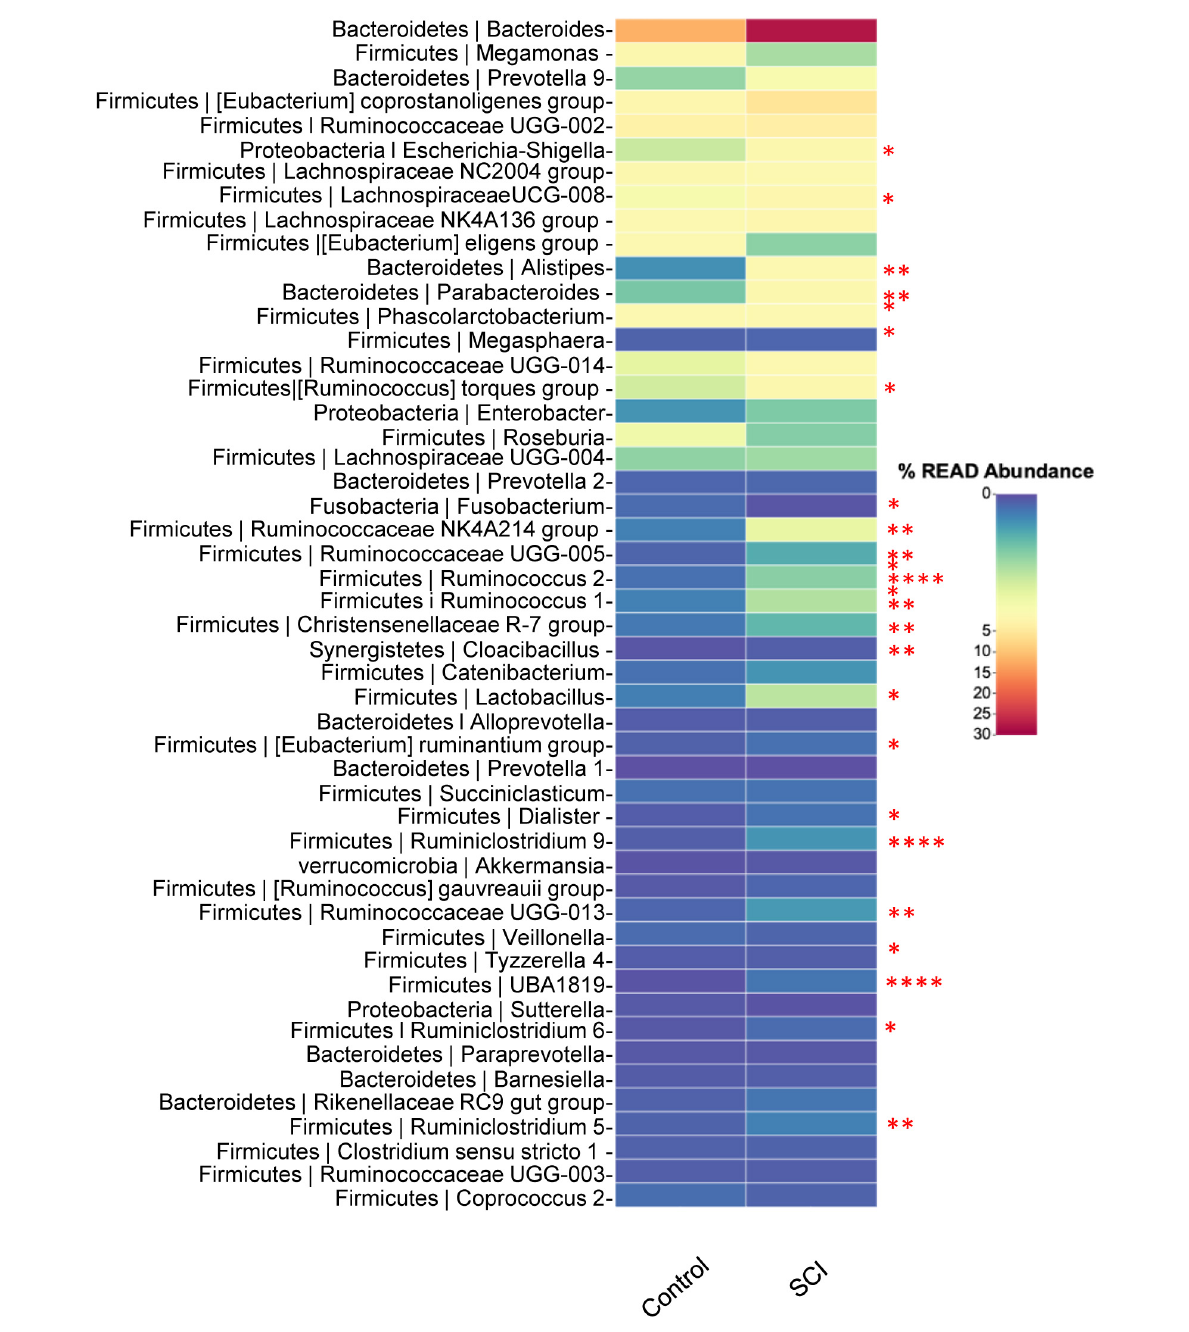
FIGURE5 Analysis of the composition of the gut microbiota at the genus level. Heat map of microbiota in healthy subjects and patients with SCI. Data was expressed as median (interquartile range); ∗ P < 0.05, ∗∗ P < 0.005, ∗∗∗∗ P < 0.0001.